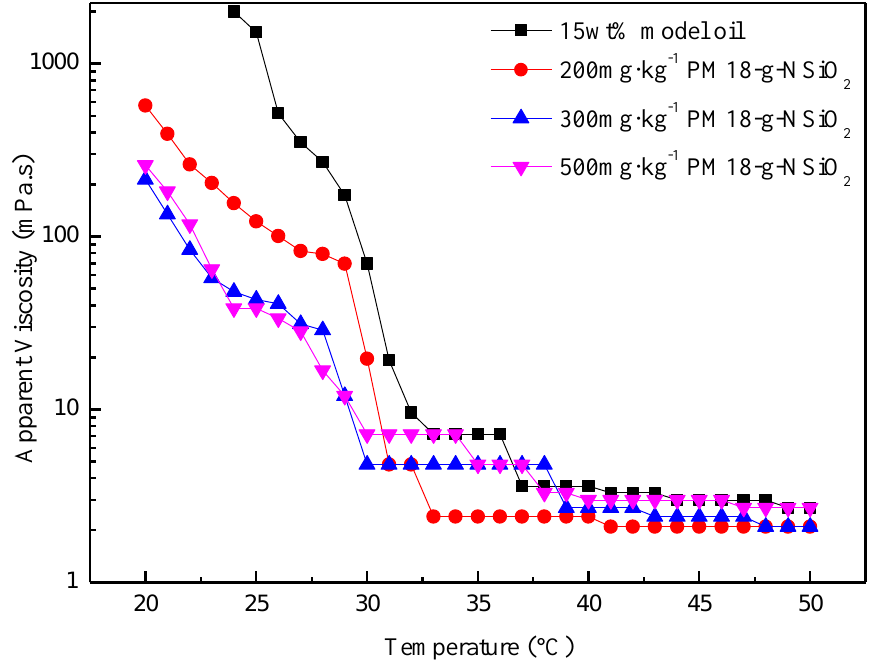
Figure 4. Semi-logarithmic curves of the viscosity versus temperature for the 15% wax model oil untreated and treated with PM18-NSiO 2